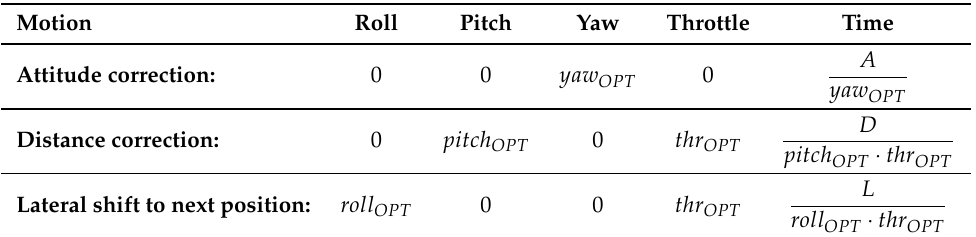
Table 1. Arguments passed to the sendVirtualStickFlightControlData() call, for each motion command.